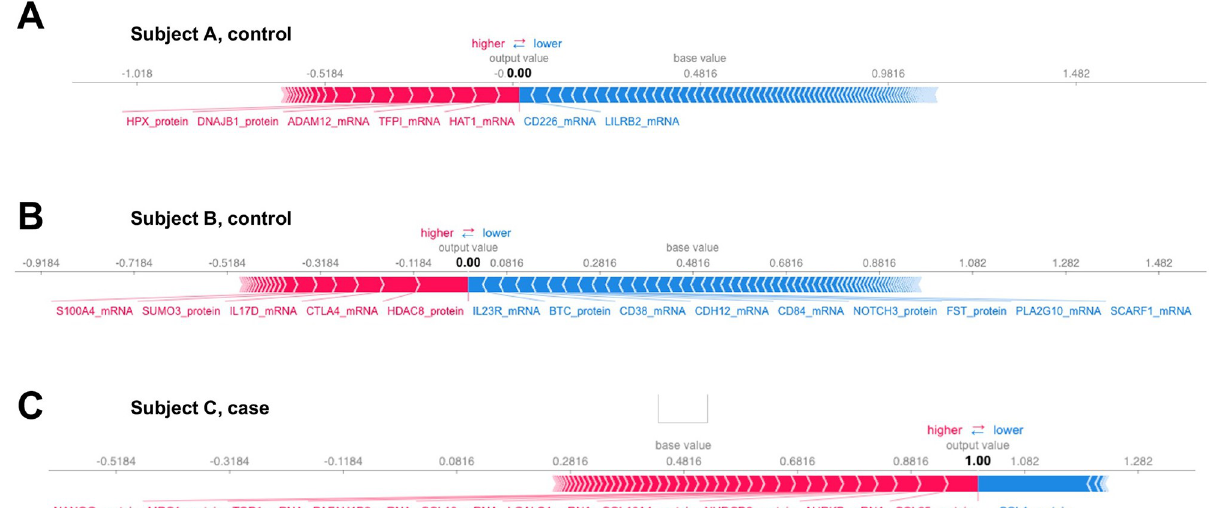
Fig 8. Important features on an individual subject. The SHAP values were calculated on two subjects with 1200 samplings to illustrate the local interpretability: Subject A (A), subject B (B), and subject C (C). Subject A and subject B are healthy controls while subject C is a COPD case. The output value is the prediction for that observation. The base value is the value that would be predicted if we have no feature information (expected value). Features pushing the prediction higher (to the right) are shown in red while those pushing the prediction lower are in blue. The bar length of each feature represents its relative contribution to the final output: a wider bar denotes a larger contribution.